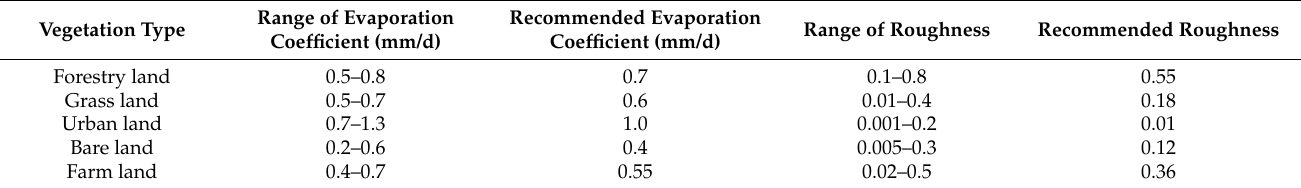
Table 1. Vegetation-based parameter ranges and recommended values.